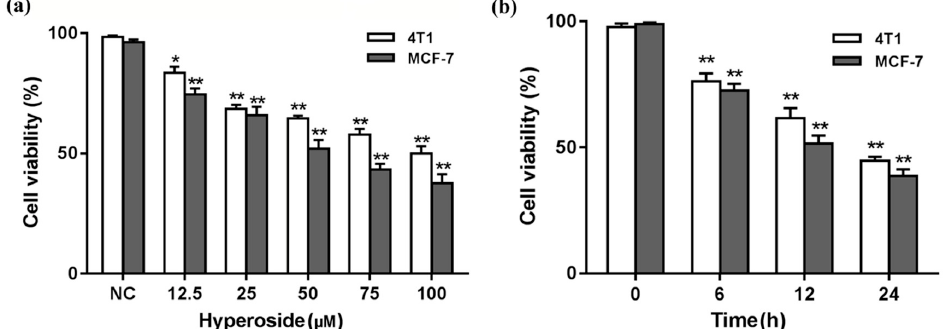
Figure 1. Effects of hyperoside on cell viability. A CCK-8 assay was used to determine the cytotoxicity of hyperoside on MCF-7 cells and 4T1 cells. Calculate cell viability according to the equation. ( a ) MCF-7 cells and 4T1 cells were exposed to different concentrations of hyperoside (12.5, 25, 50, 75, or 100 µ M); ( b ) MCF-7 cells and 4T1 cells were exposed for different time periods (6, 12, or 24 h) of hyperoside. Data are expressed as mean ± SD of three independent experiments. * p < 0.05; ** p < 0.01 (Student’s t